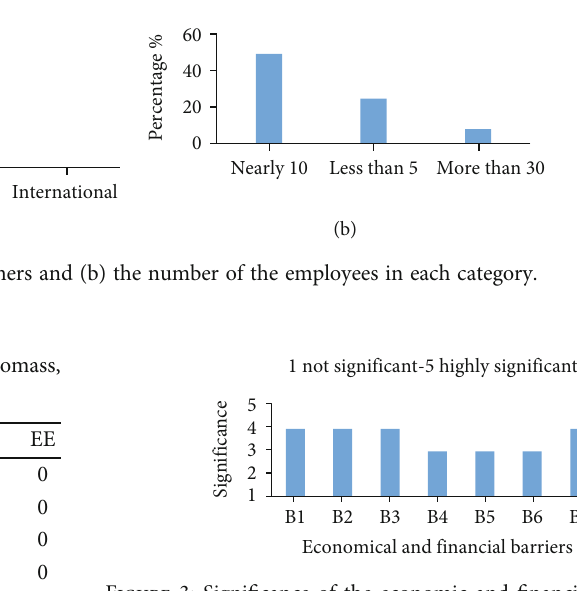
Figure 3: Signi fi cance of the economic and fi nancial obstacles to the promotion of RE and EE. B1: market design issues, hindering the integration of renewable energies; B2: di ffi culty in Power Purchase Agreement (PPA) negotiations; B3: unstable prices in the spot market; B4: longer economic recovery periods; B5: lack of modeling of externalities; B6: limited access to fi nancing; B7: lack of subsidized loans for small or small-scale facilities. Figure 4 indicates the signi fi cance of the institutional and regulatory barriers to the promotion of RE. Figure 5 indicates the signi fi cance of public awareness and information barriers to the promotion of RE.